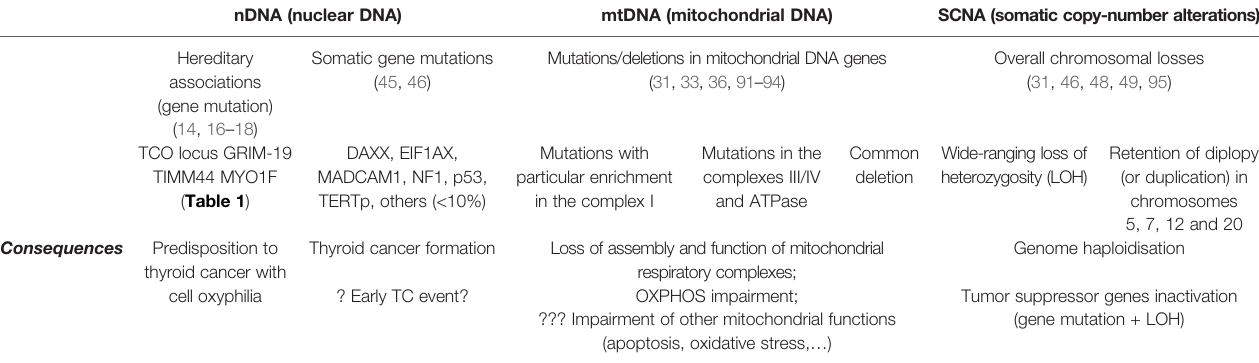
TABLE 2 | Summary of the major alterations reported in oncocytic thyroid